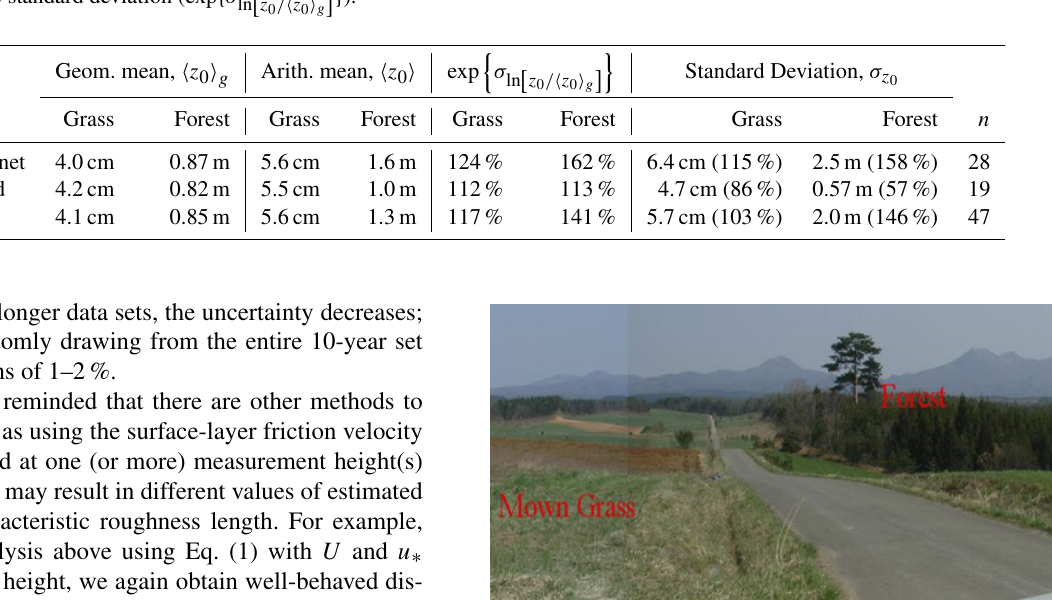
Table 1. Means (geometric and arithmetic) and corresponding deviations in z 0 , surveyed from two groups of wind resource experts for the two terrain types shown in Fig. 2. For conventional (linear) standard deviation σ z with the logarithmic standard deviation (exp { σ